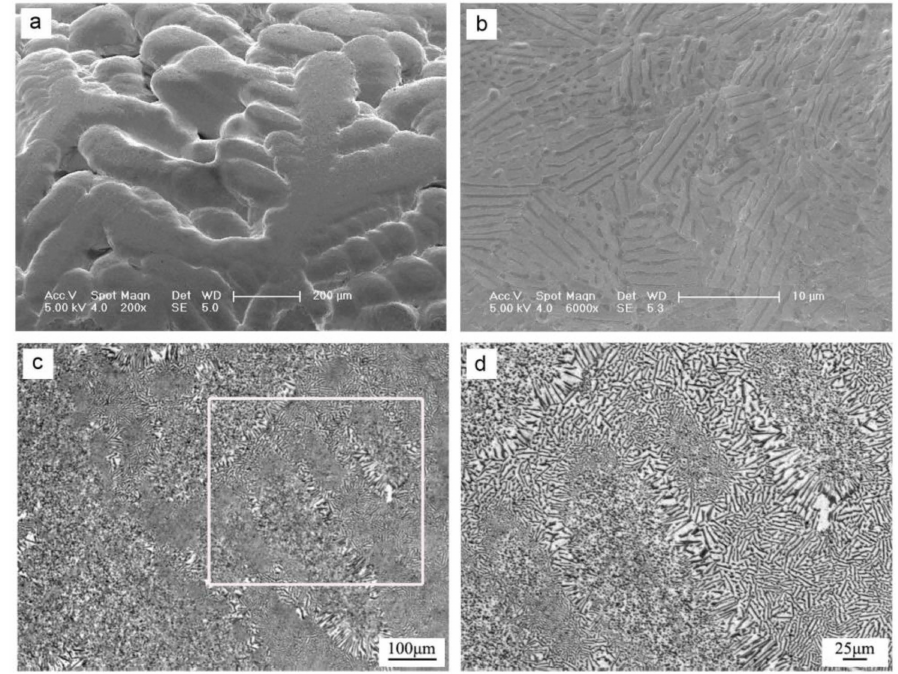
Figure 4. Microstructures of Ag-28.1Cu eutectic alloy undercooled by 85 K, ( a ) the surface structure with dendritic morphology at low magnification, ( b ) lamellar eutectics in the surface dendrite arms at high magnification, ( c ) the internal structure with dendritic morphology at low magnification, and ( d ) anomalous eutectics and the lamellar eutectics around them in the quadrilateral region at high